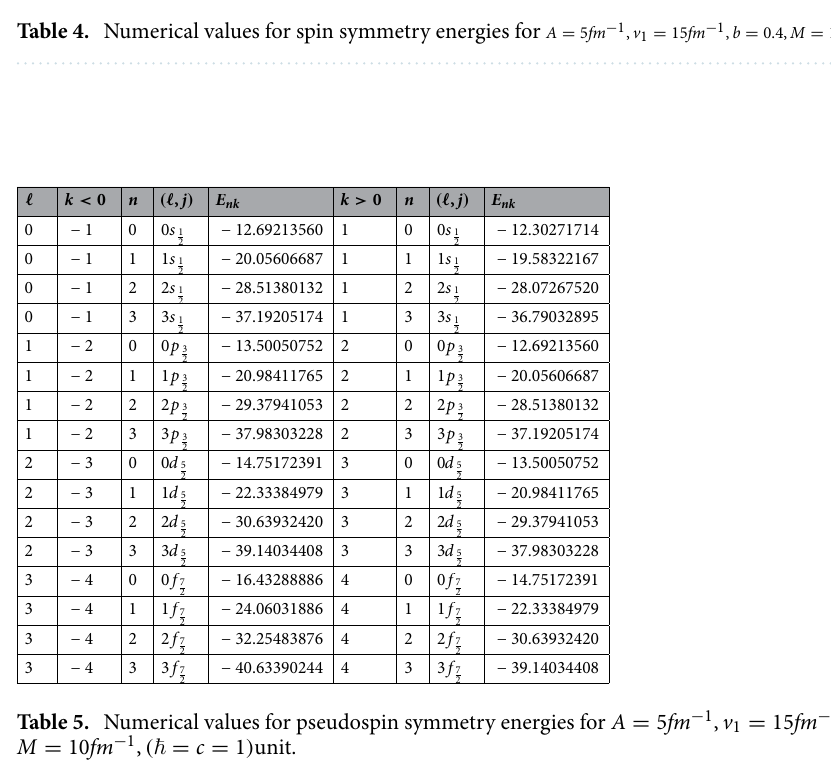
Table 4. Numerical values for spin symmetry energies for A